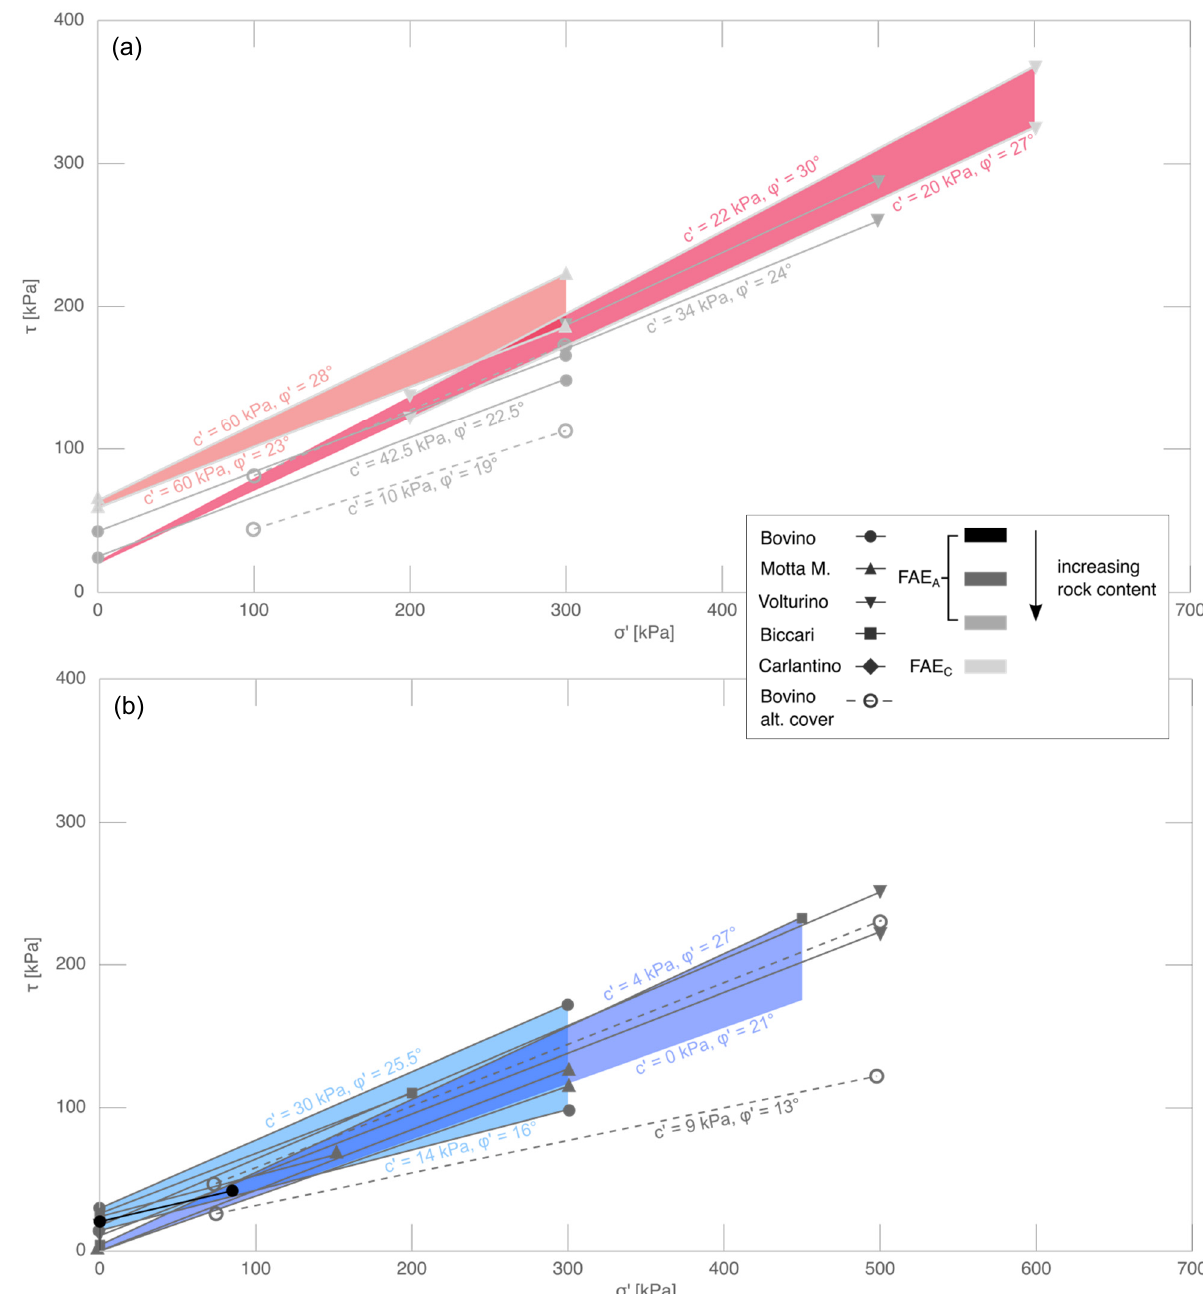
Figure 18. Mohr–Coulomb peak shear strength envelopes: ( a ) rocky; ( b ) clayey Faeto Flysch. In general, as expected, samples from the FAE C (Figure 18a) corresponded to higher strength with respect to the FAE A . The peak failure envelopes for FAE C varied in the range (c (cid:48) = 60 kPa, ϕ (cid:48) = 23 ◦ )–(c (cid:48) = 60 kPa, ϕ (cid:48) = 28 ◦ ), measured in the low-stress range at Motta